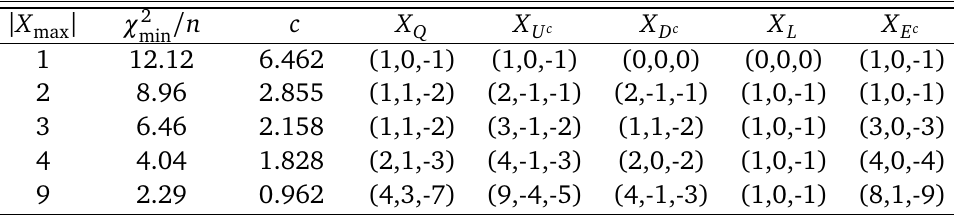
| ≤ 6 in the case with three generations max